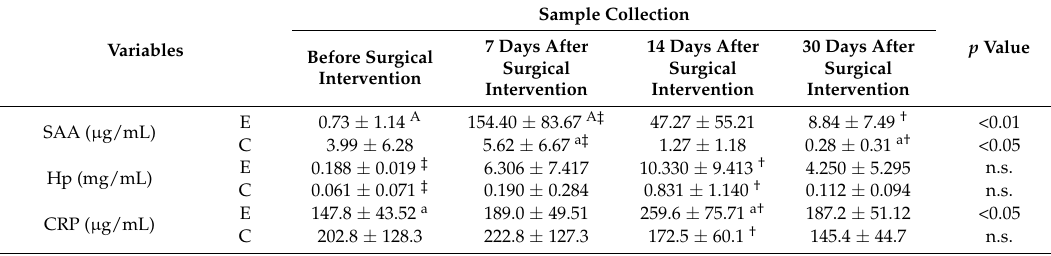
Table 3. Changes in the concentrations of SAA, Hp and CRP in the experimental (E) and control (C) group of sheep before surgical intervention and in the postoperative period (mean ± SD).